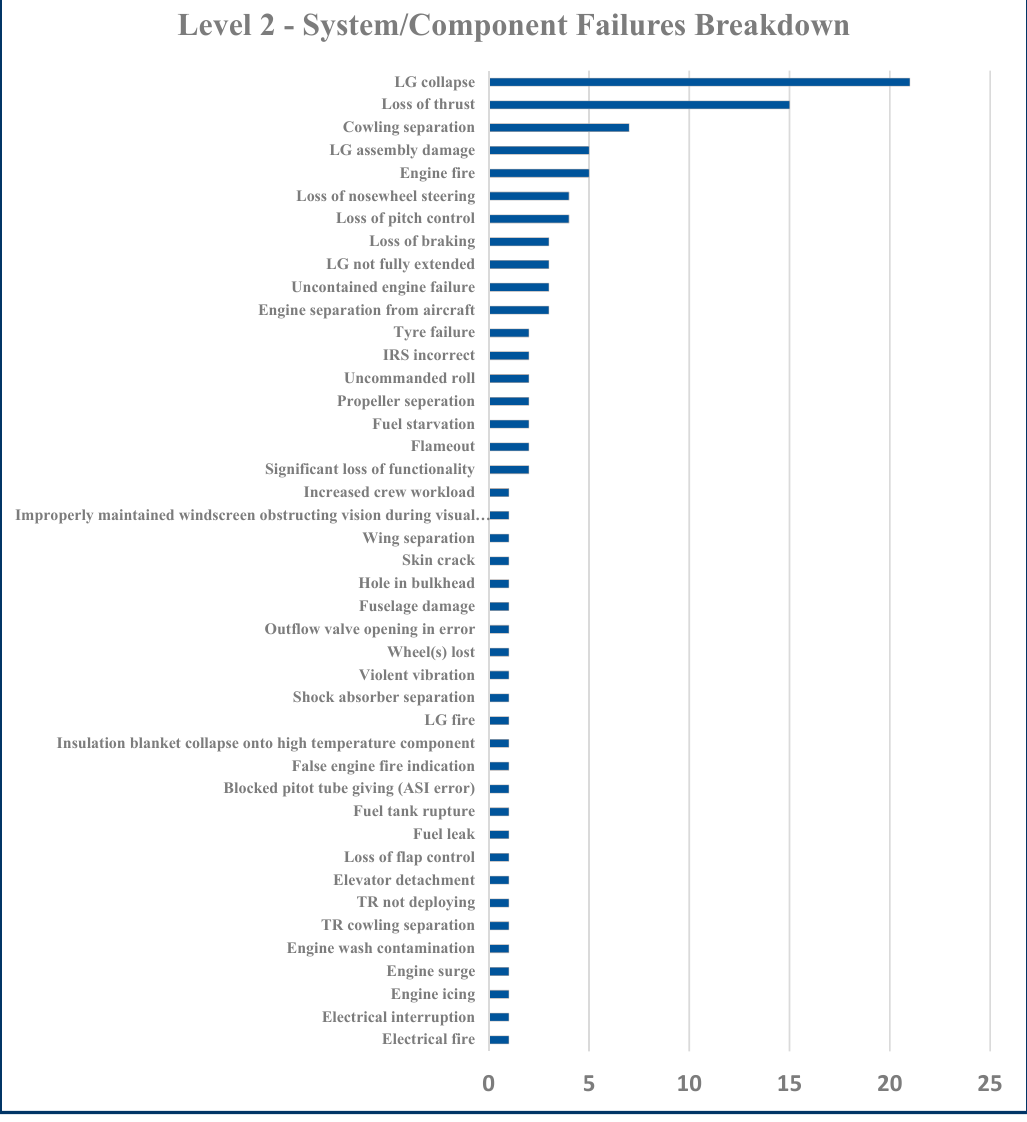
Figure 6. Level 2 top level system/component failures.